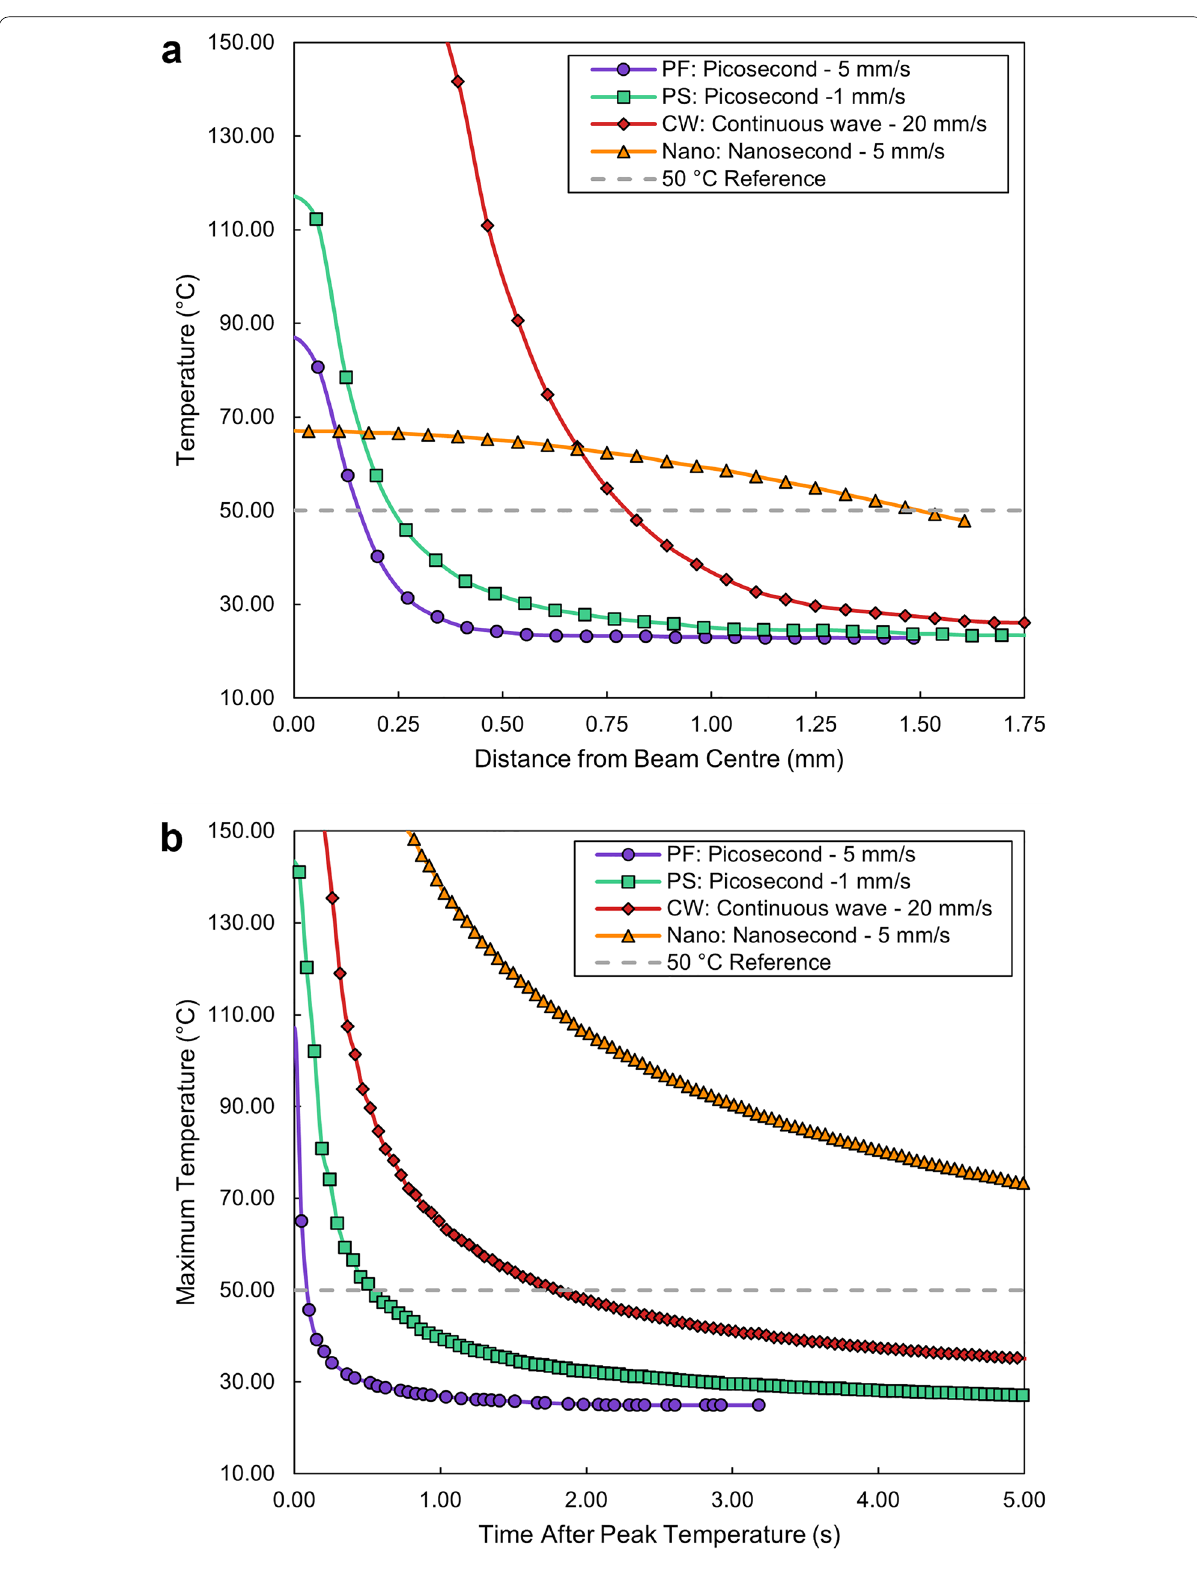
Figure 7 (See legend on previous